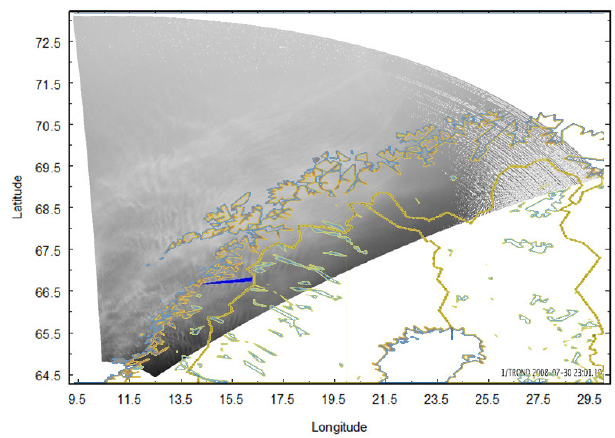
Figure 2. Image of the noctilucent cloud observed by camera from Trondheim on 30 July 2008 at 23:01UT projected onto latitude and longitude (given in